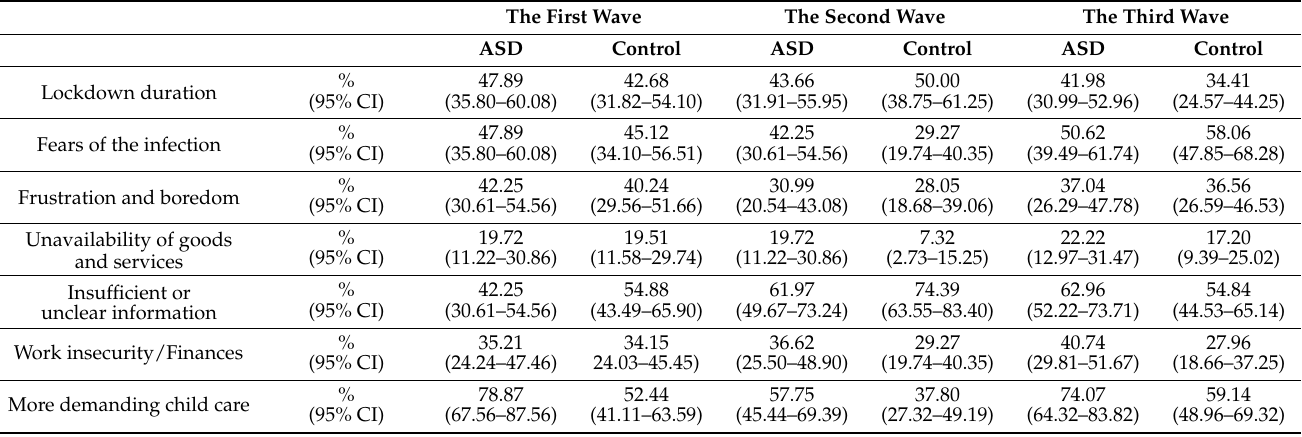
Table 3. Changes in the most prevalent stressors for the parents of children with ASD and parents of neurotypical